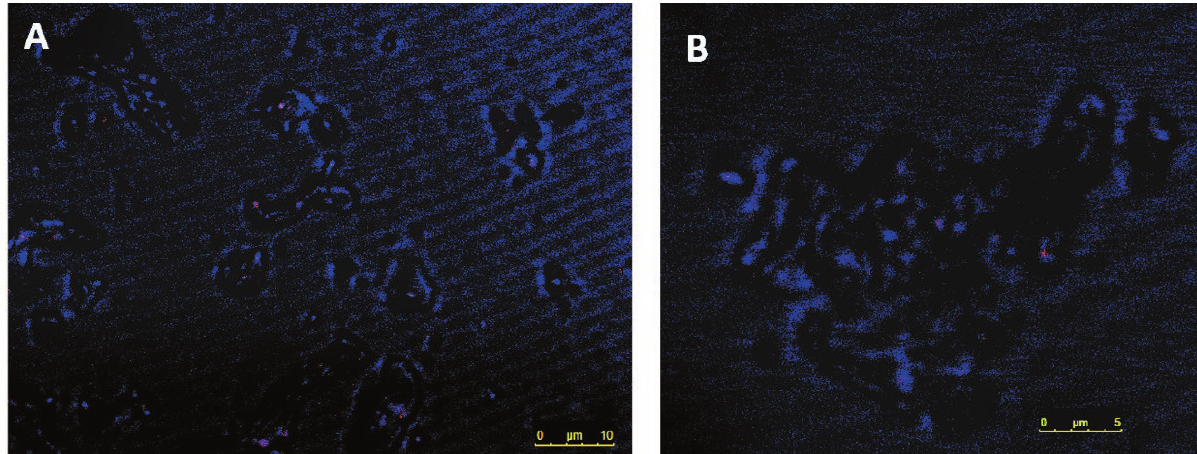
Figure 1. Display of Sukkula internal-domain distributions in barley root preparations via FISH.